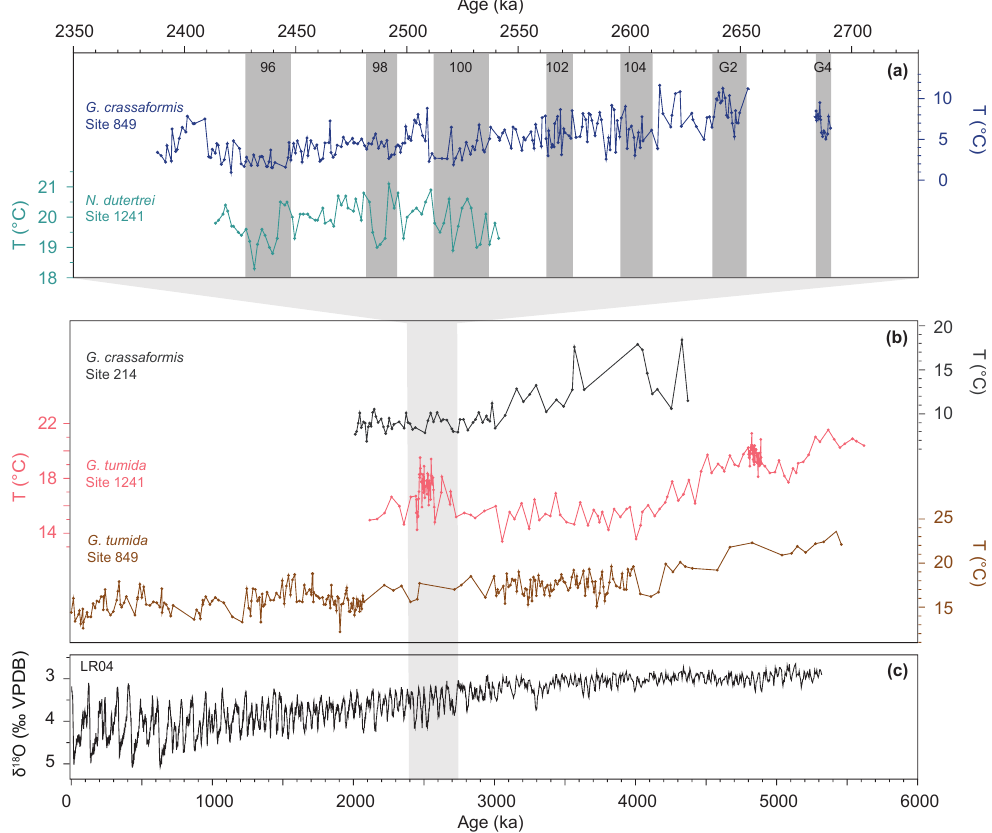
Figure 6. Comparison of selected thermocline-temperature records from the tropical Pacific for the past ∼ 6Myr (bottom) and the ∼ 2 . 75– 2.4Ma interval (top). (a) High-resolution Mg / Ca-based temperature records of thermocline-dwelling species from Site 849 (blue; this study) and Site 1241 (cyan; Groeneveld et al., 2014). (b) Low-resolution Mg / Ca-based temperature records of thermocline-dwelling species from Site 214 (grey; Karas et al., 2009), Site 1241 (pink; Steph et al., 2006a) and Site 849 (brown; Ford et al., 2012). (c) Benthic oxygen isotope record (LR04 stack; Lisiecki and Raymo, 2005). Light grey shading in (b) and (c) marks the investigated time period of this study. Grey bars in (a) highlight glacial